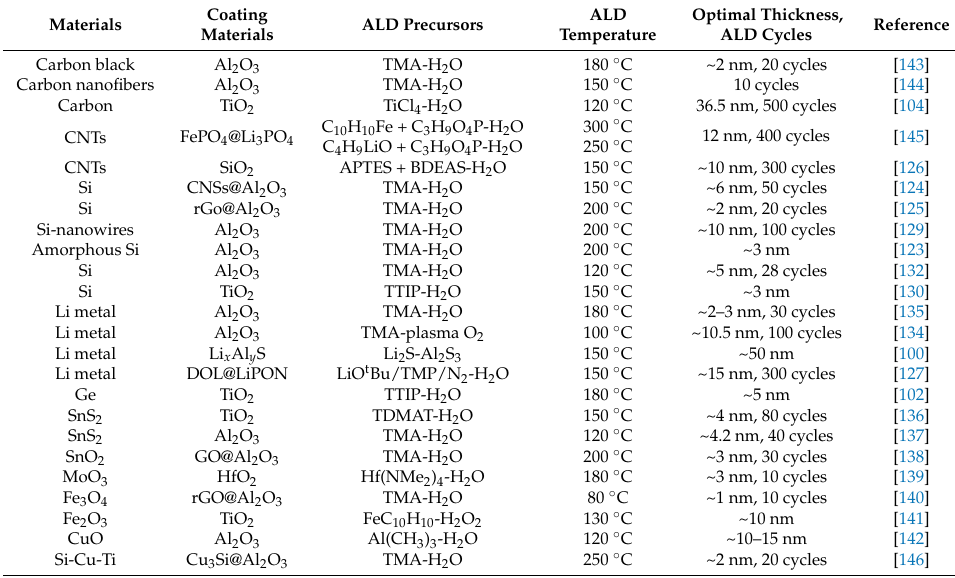
Table 2. Summary of the ALD surface coatings on the